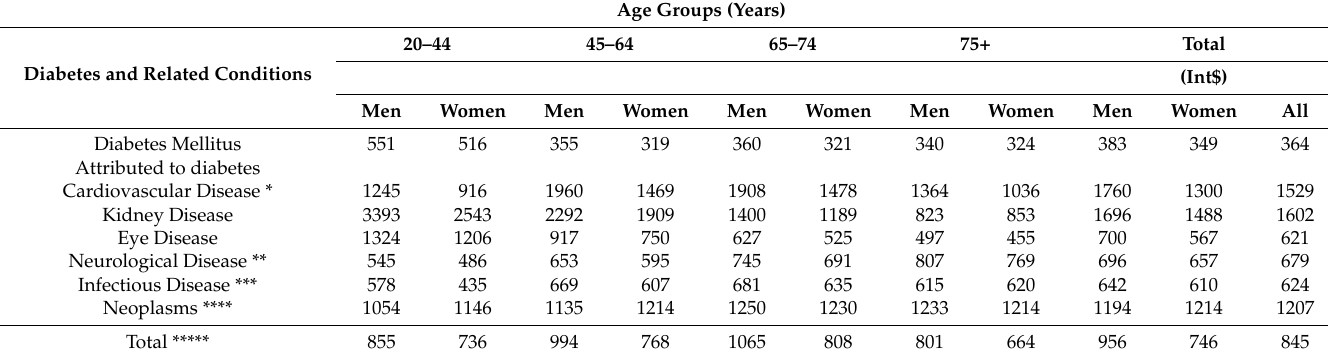
Table 2. Average hospitalization cost (Int$) due to diabetes and related conditions by age-group and sex, SUS, Brazil,